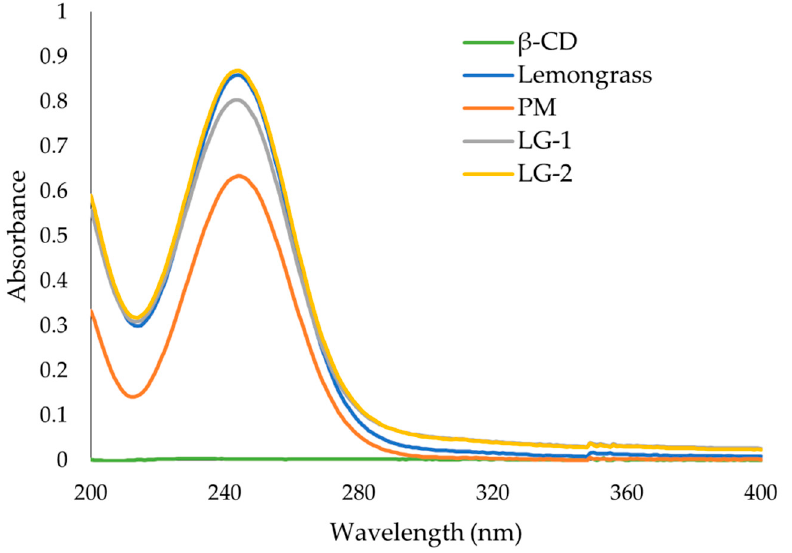
Figure 8. UV-Vis spectra of β -cyclodextrin ( β -CD), lemongrass (LG) essential oil, physical mixture of both (PM) and the inclusion complexes LG-1 and LG-2. Solutions were prepared in water and have the same β -CD or essential oil concentration where applicable.